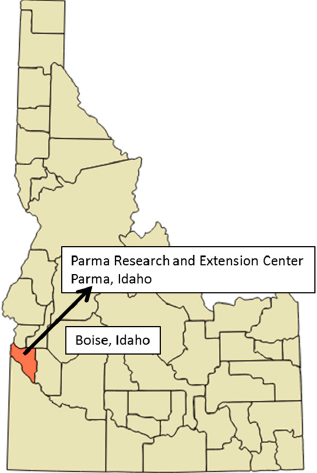
Figure 1. Study area map of experimental